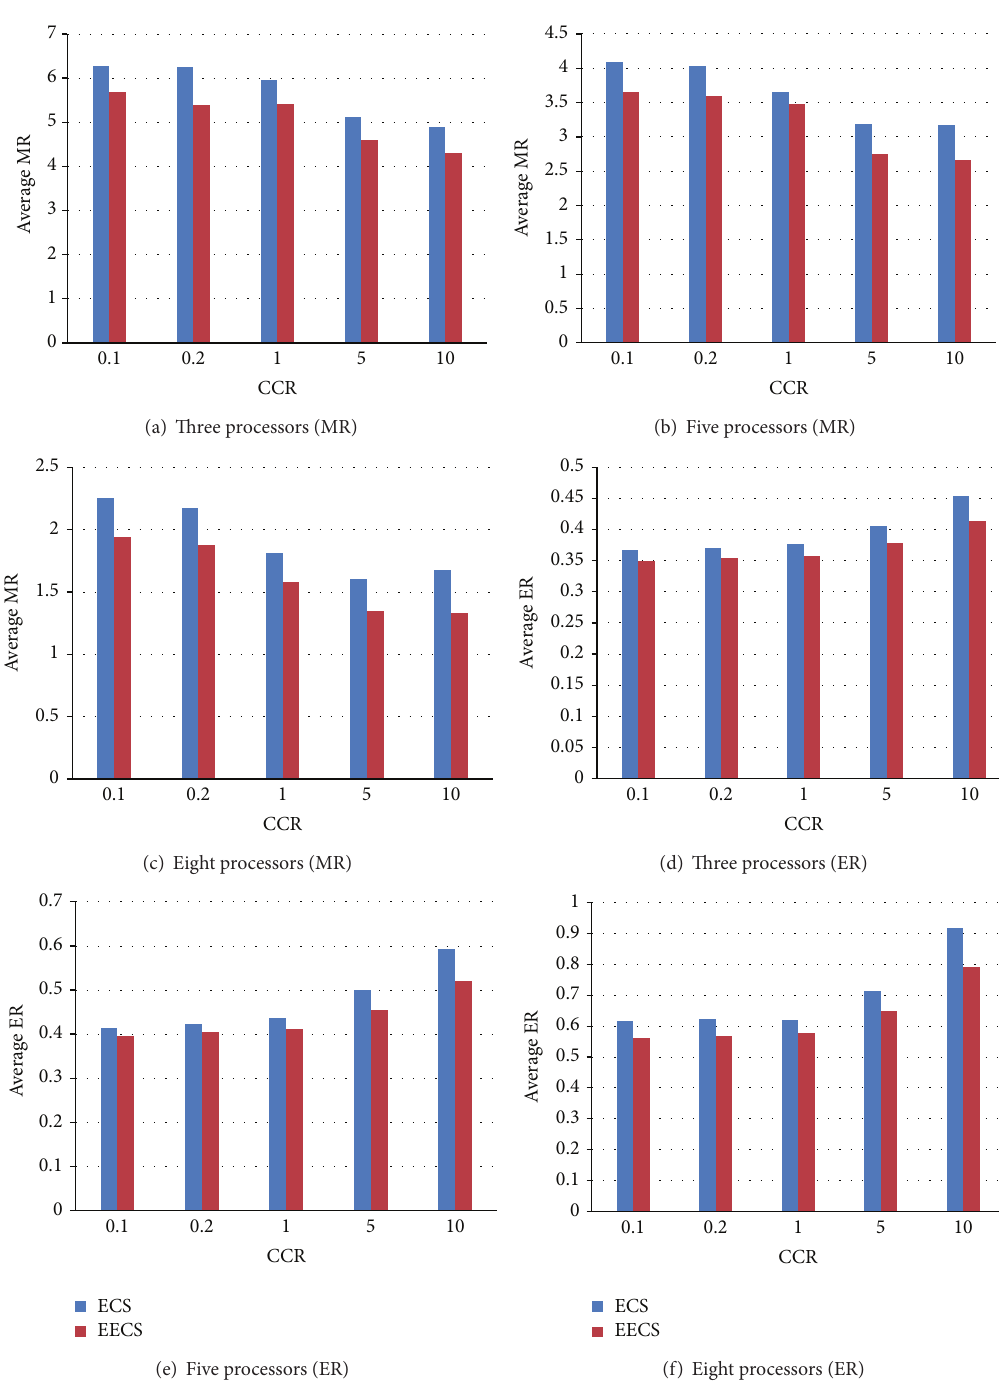
Figure 8: Random DAGs (different sizes of